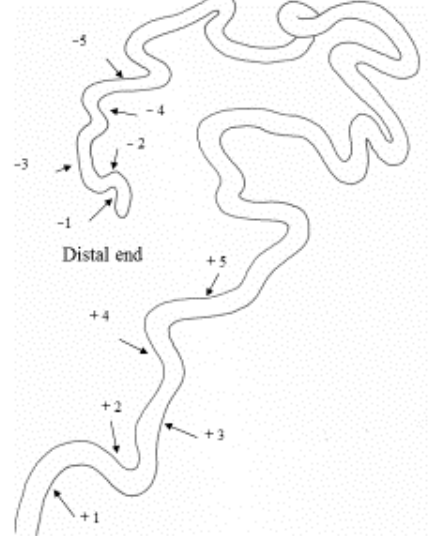
Figure 1. Structure of the seminal vesicle in the desert locust, Shistocerca gregaria . Numbering was made from the proximal end (+1, +2, +3...) and the distal end ( − 1, − 2, − 3…) of the seminal vesicle.